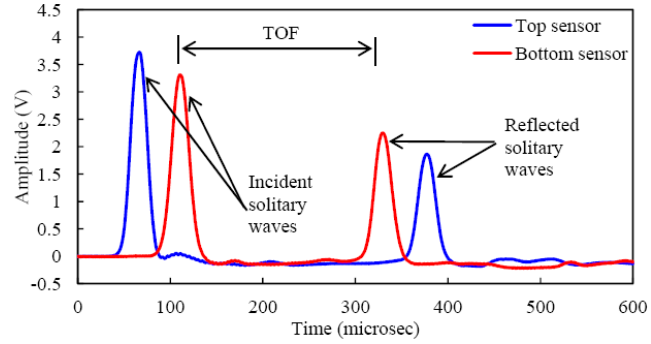
Figure 6. Typical waveforms measured by the bead